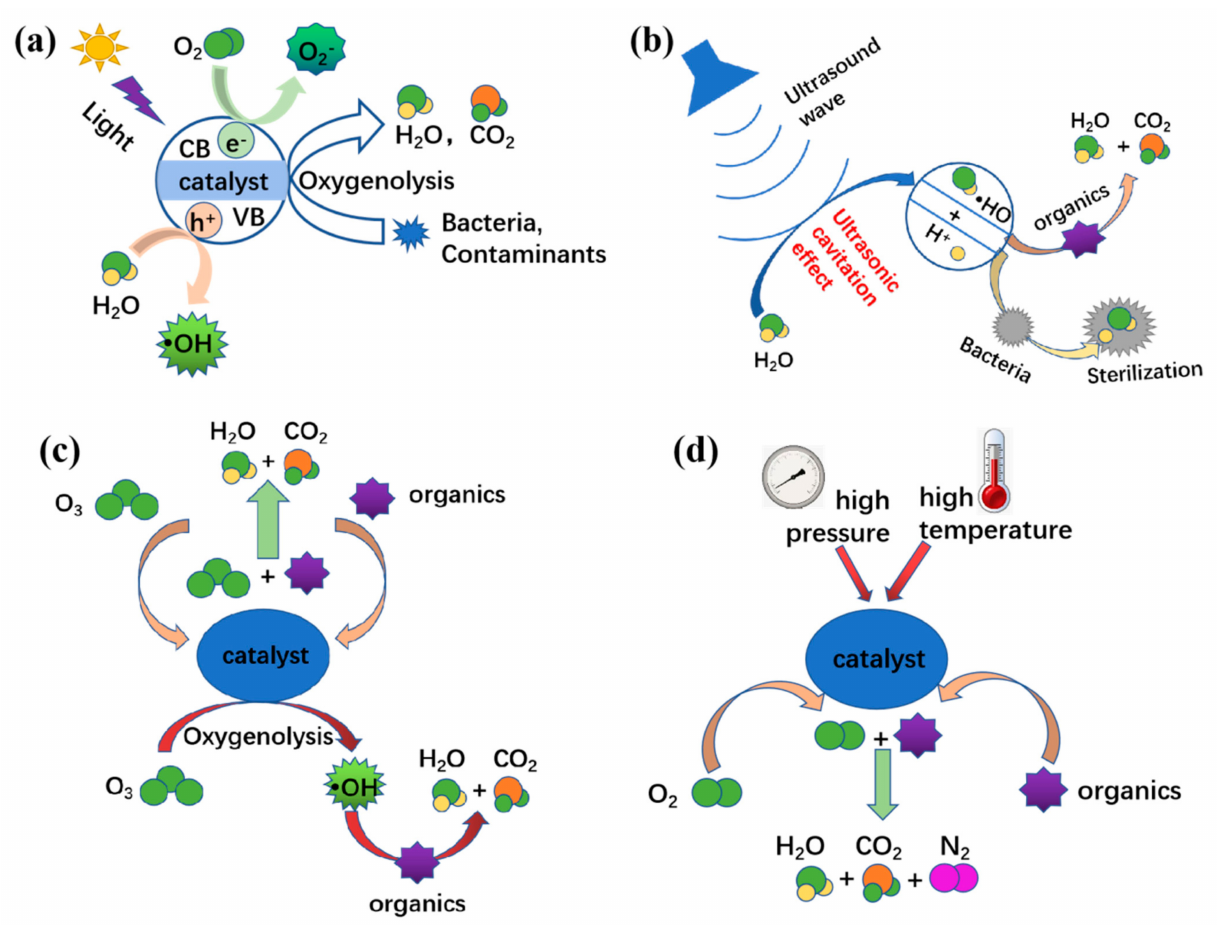
Figure 1. Four commonly used AOPs techniques: ( a ) photocatalytic oxidation technology; ( b ) ultra- sonic oxidation technology; ( c ) ozonation technology; ( d ) wet oxidation